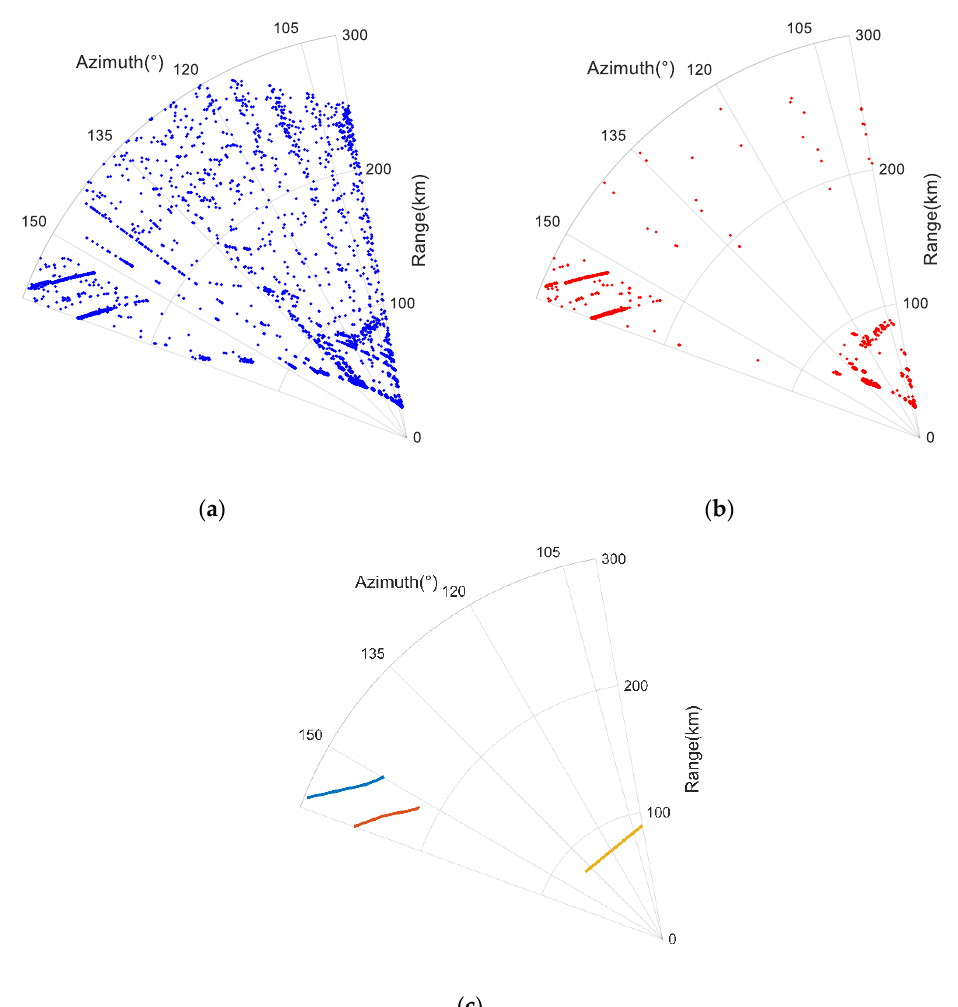
Figure 13. The contrast of before and after the suppression and the comparison with ADS-B dataset: ( a ) field data before suppression; ( b ) clutter suppression result; ( c ) real-time fights information from ADS-B dataset.